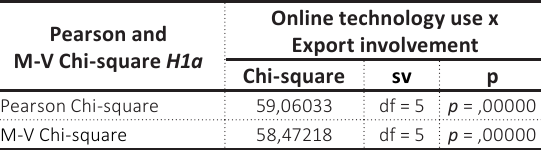
Table 1. Online technology use and Company age Pearson and